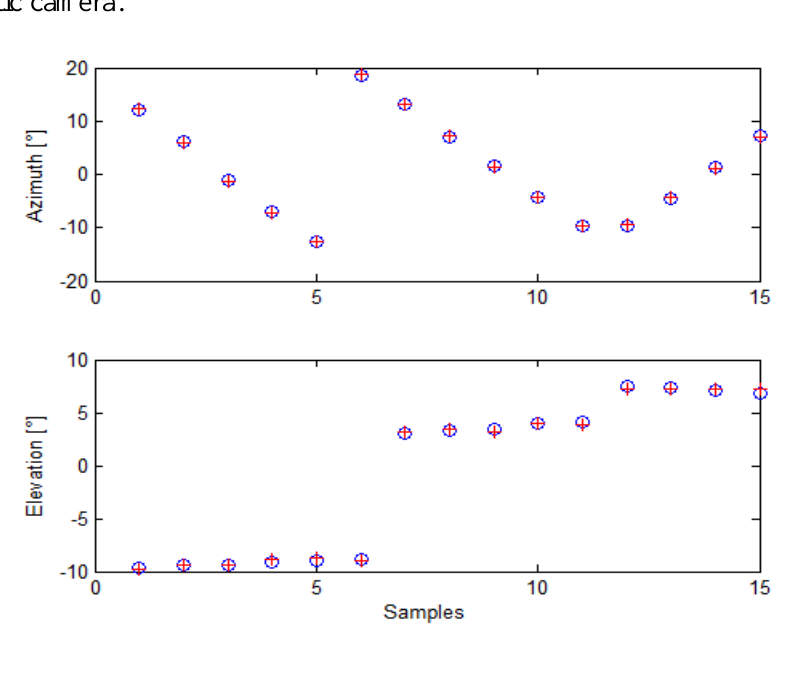
Figure 10. Target angular positions as extracted from images (blue circles) and from GPS/AHRS measurements and computed rotation matrix (red crosses) for the color